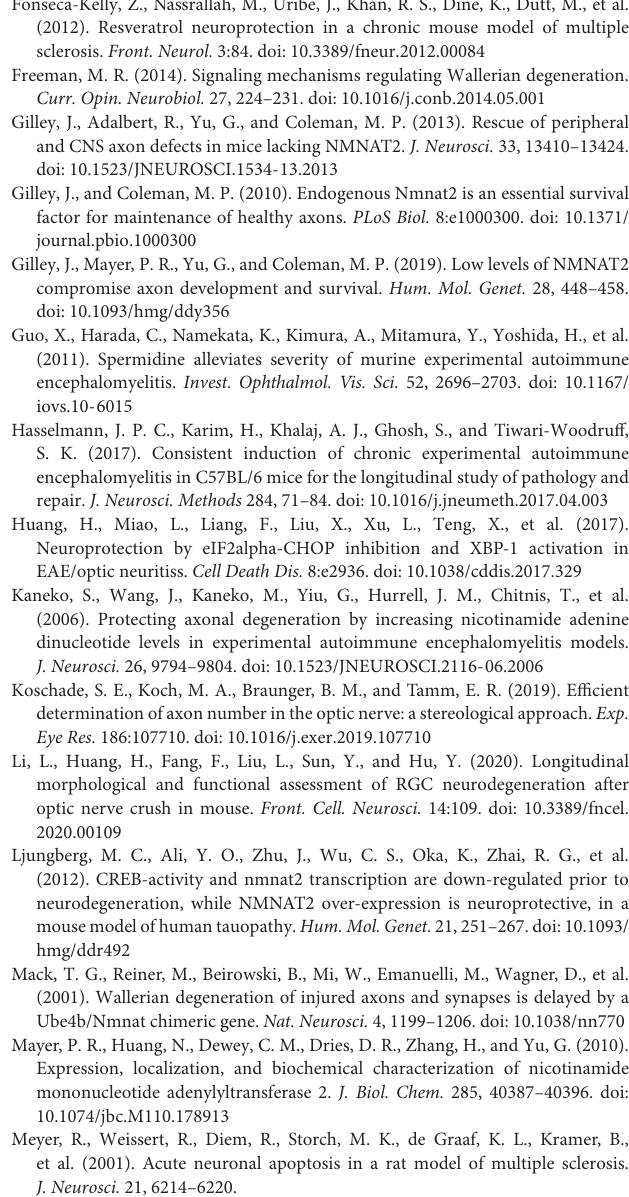
Supplementary Figure 1 | No toxicity by NMNAT2 overexpression in naïve mouse retina. (A) Left: representative wave forms of PERG 10 weeks after AAV2 intravitreal injection. Right: quantification of P1-N2 amplitude of PERG. n = 3. Data are presented as means ± SEM, ns: no significance, paired two-tailed t -test of NMNAT2-injected eyes and contralateral control eyes injected with control AAVs. (B) Visual acuity measured by OKR 10 weeks after AAV2 intravitreal injection. c/d: cycle/degree. n = 3. Data are presented as means ± SEM, ns: no significance, paired two-tailed t -test of NMNAT2-injected eyes and contralateral control eyes injected with control AAVs. (C) Representative OCT images of mouse retinas in mice before and after AAV intravitreal injection. GCC: ganglion cell complex, including RNFL, GCL, and IPL layers; indicated as double end arrows. BL: baseline, before immunization. (D) Quantification of GCC thickness measured by OCT in eyes injected with AAV-NMNAT2 and contralateral eyes injected with control AAVs. n = 3. Data are presented as means ± SEM, ns: no significance, paired two-tailed t -test of NMNAT2-injected eyes and contralateral control eyes